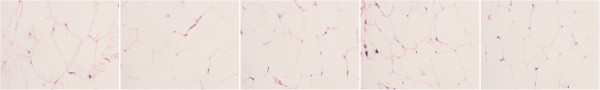
Histological changes of epididymal adipose tissue in rats (HE Stain, × 400).